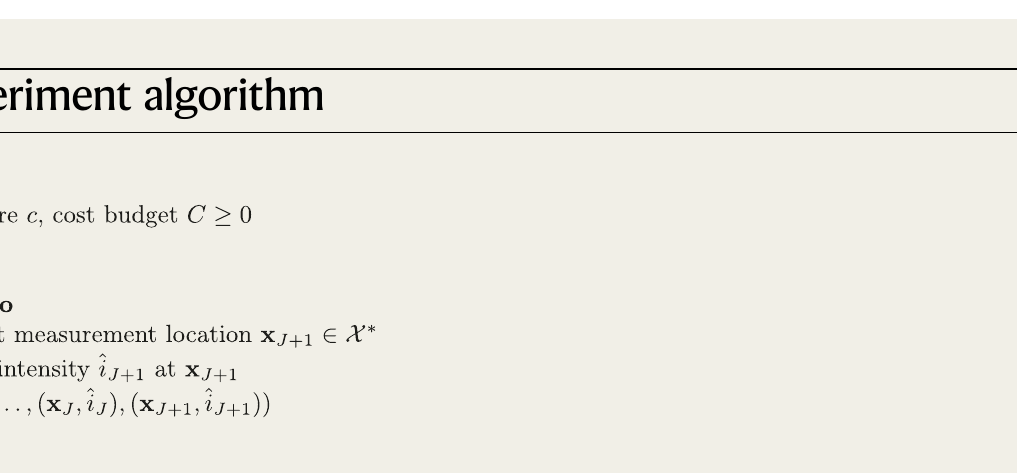
Fig. 1 | Example of an intensity function and a corresponding inef fi cient and ef fi cient experiment. For the Q direction, we use relative lattice units (r.l.u.). a Intensity function on X = ½ 2 : 3,3 : 3 (cid:3) × ½ 2 : 5,5 : 5 (cid:3) along the Q direction (0, 0, 1) with offset(1,1,0)andenergytransfer.Thecolorspectrumrangesfromblue(lowsignal)